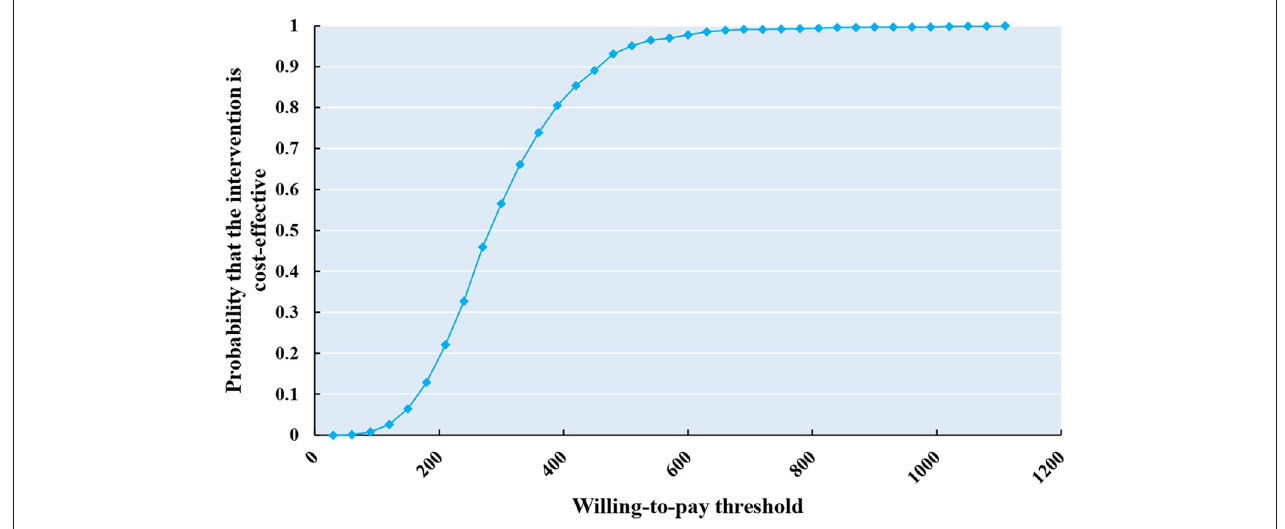
FIGURE 4 | CEAS of improvement of insomnia